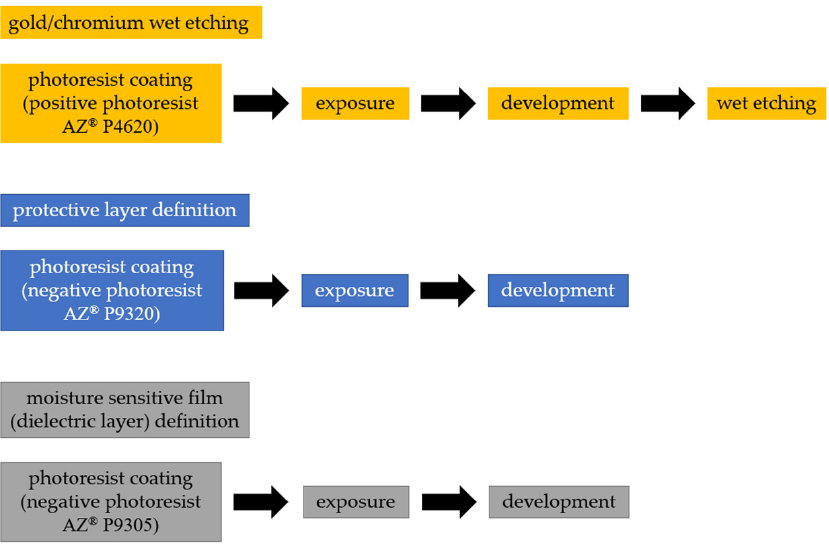
Figure 3. Lithography process.